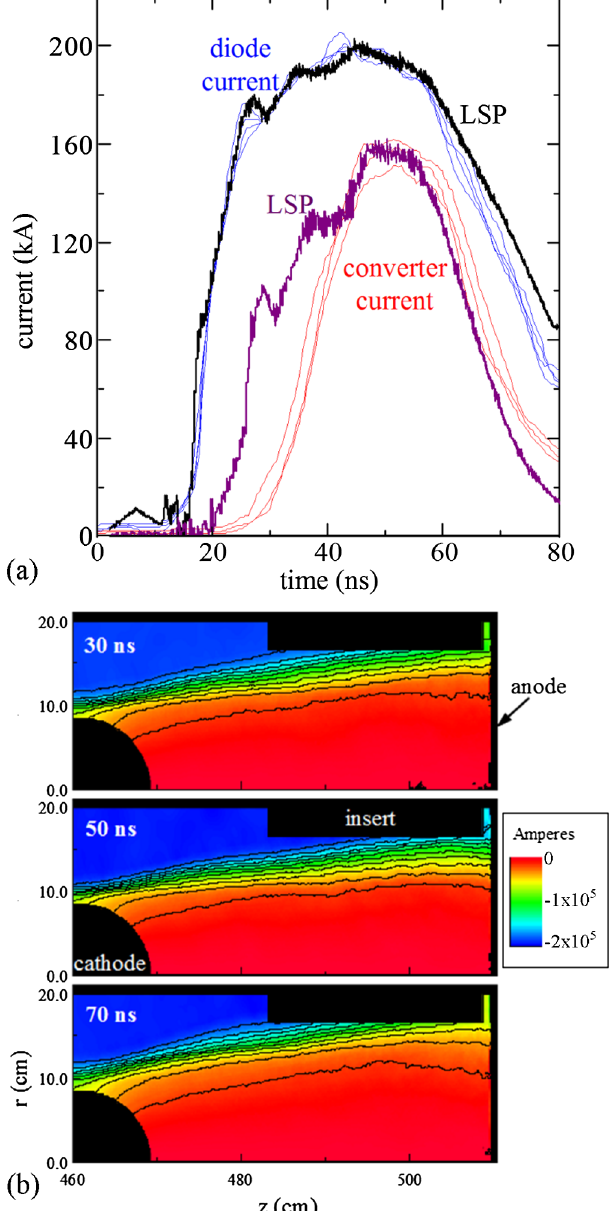
FIG. 3. (a) Electron current in the diode and on the converter for four sequential 40 cm gap shots (thin curves) compared to LSP predictions (heavier, noisy curves). (b) LSP rB θ distributions (current enclosed within radius r ) in the diode at 3 times (dashed lines in Fig. 3a) for a 40 cm gap. Overlaid current contours are in 10%